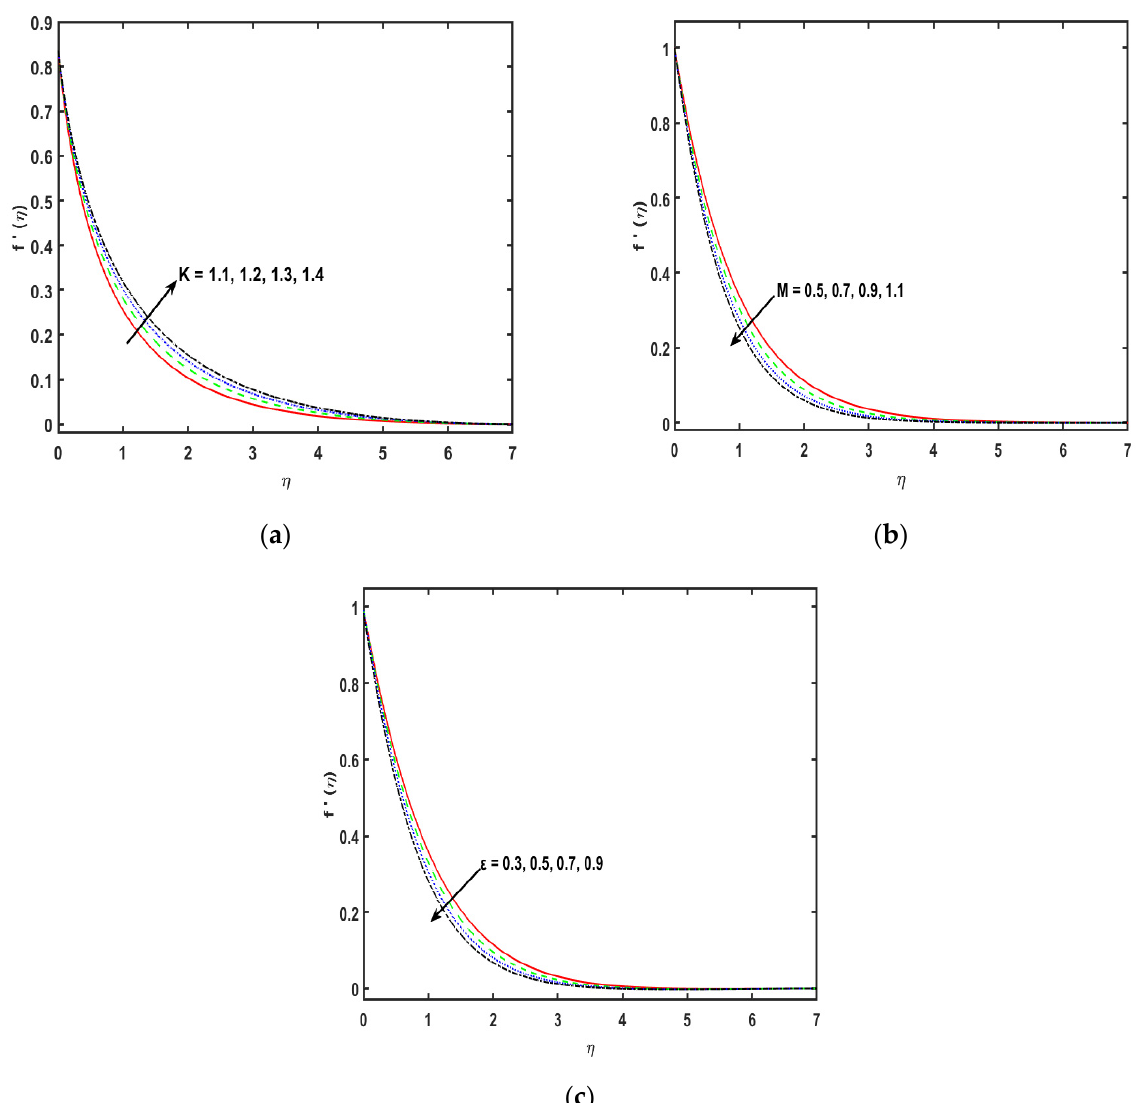
Figure 2. ( a – c ): Variation in 𝐾, 𝑀 and 𝜀 against 𝑓′(𝜂) , respectively.